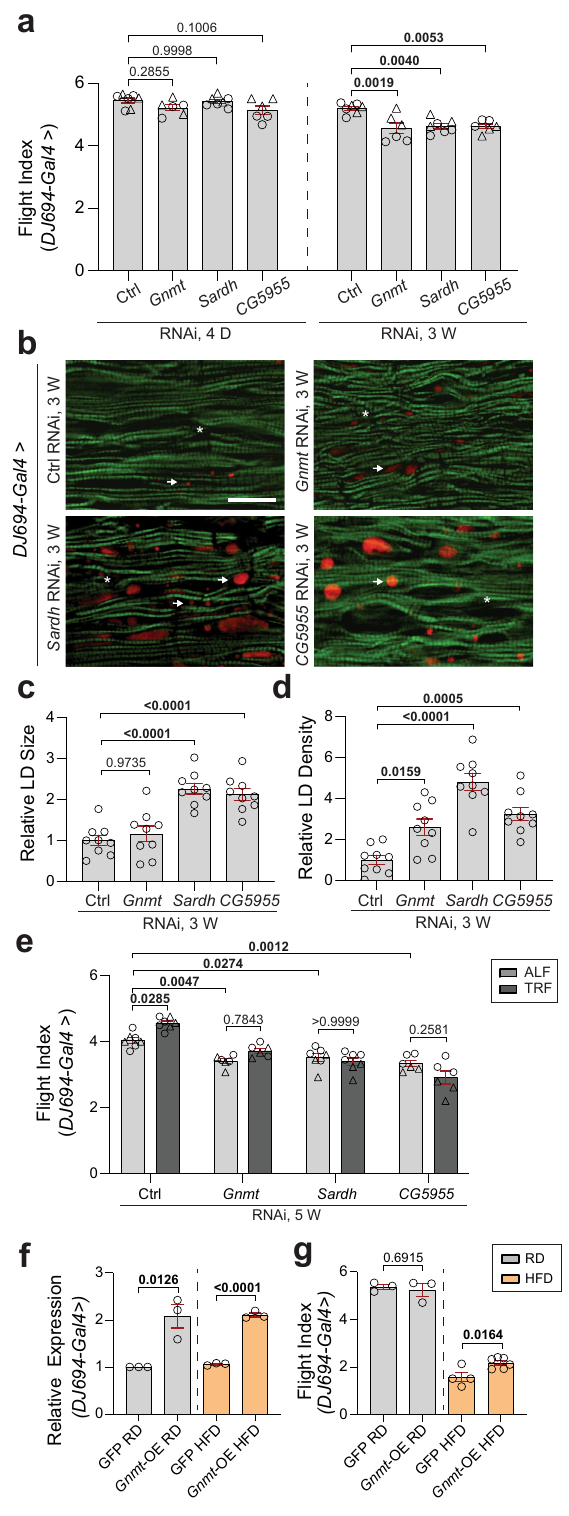
Fig. 3 | Functional and cytological validation of Gnmt , Sardh , and CG5955 KD using DJ694-Gal4 . a Flight performance of female fl ies with DJ694-Gal4 -driven KD of Gnmt , Sardh ,or CG5955 at4daysand3weeksofage.TwoindependentRNAilines wereusedforcontrolandeachgene.Flightindicesplottedascohortsof10 – 20 fl ies fromindependentRNAilineswereindicatedwiththesymbolcircleortriangle.#of cohorts per RNAi line per condition = 3; # of fl ies per genotype per age group = 86 – 130.Details of precise N areinSource Data. Mean± SEM.One-way ANOVAwith Sidak post hoc tests. b Fluorescence images of the IFMs from 3-week-old female fl ies with DJ694-Gal4 -driven KD of Gnmt , Sardh , and CG5955 upon staining with phalloidin (green) and Nile Red (red puncta). More accumulation of lipid (arrows) and actin-containing myo fi brillar disorganization (asterisks) was detected in IFMs upon KD of Gnmt , Sardh , and CG5955 , compared with age-matched control. The scale baris 20 µ m. c , d Intramuscular lipid quanti fi cation (lipid droplet size ( c ) and density( d )). N =9fromthree fl ies ’ IFMpergenotype.Mean±SEM.One-wayANOVA with Sidak post hoc tests. e Flight performance of 5-week-old female fl ies with DJ694-Gal4 -driven KD of Gnmt , Sardh , and CG5955 under ALF and TRF. Two inde- pendent lines were tested. Flight indices were plotted as cohorts of 10 – 20 fl ies. Resultsfrom independent RNAi lines wereindicated with symbol circle or triangle. # of cohorts per RNAi line per condition = 3 – 4; # of fl ies per genotype = 67 – 98. Details of precise N are in Source Data. Mean ± SEM. Two-way ANOVA with Sidak post hoc tests. f Relative expression of Gnmt in 3-week-old female fl ies with Gnmt overexpression using DJ694 driver. Experimental fl ies were fed with RD or HFD. N =3 biological replicates. Mean ± SEM. Two-sided unpaired t -tests. g Flight per- formance in 3-week-old female fl ies with Gnmt overexpression driven by DJ694 . Experimental fl ies were fed with RD or HFD. Flight indices were plotted as cohorts of 10 – 20 fl ies. # of cohorts per condition = 3 – 5; # of fl ies per genotype per age = 40 – 100.Detailsofprecise N areinSourceData.Mean±SEM.Two-sidedunpaired t - tests. Source data are provided as a Source Data fi